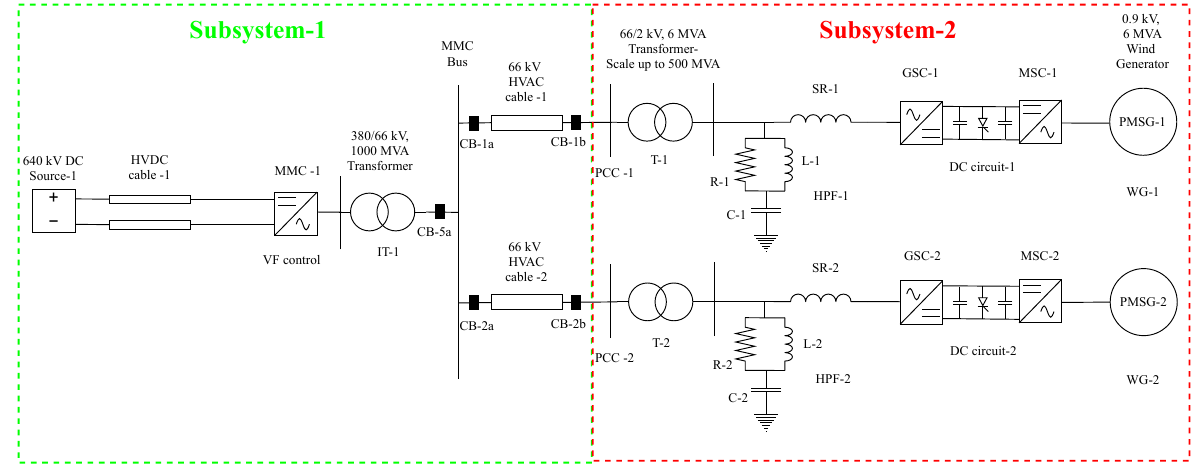
Figure 4. OWF-1 and OWF-2 connected in parallel to MMC-1.